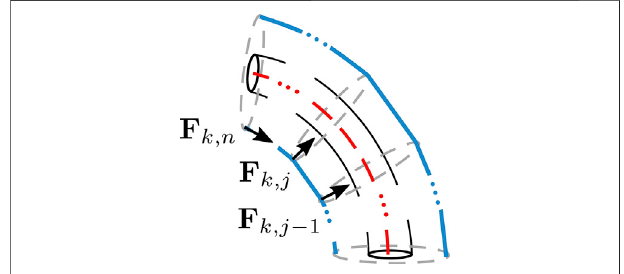
FIGURE 7 | Diagrammatic representation of the forces F k , j applied by a discrete tendon path, where the portion between two disks is a line